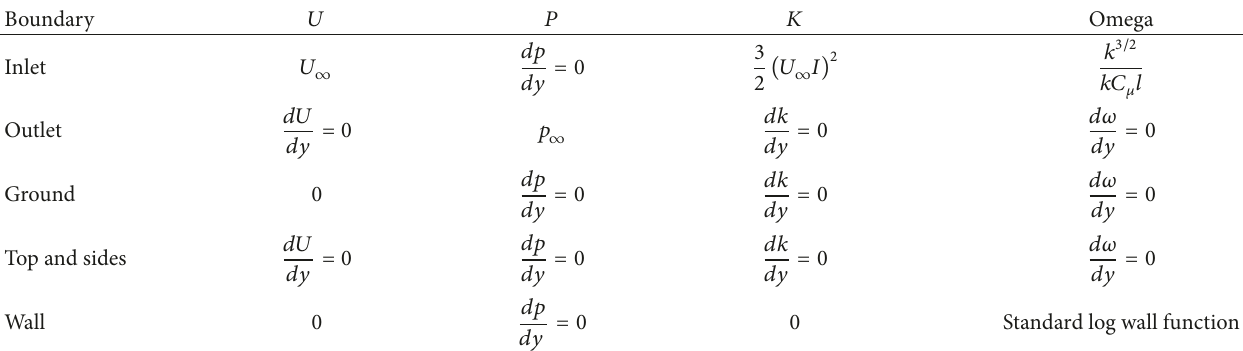
Table 3: Boundary